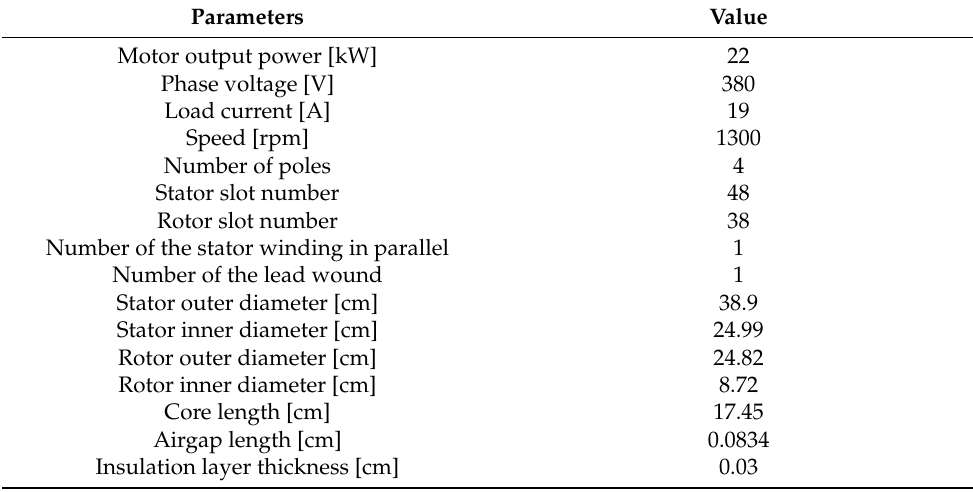
Table 2. Parameters of the motor.